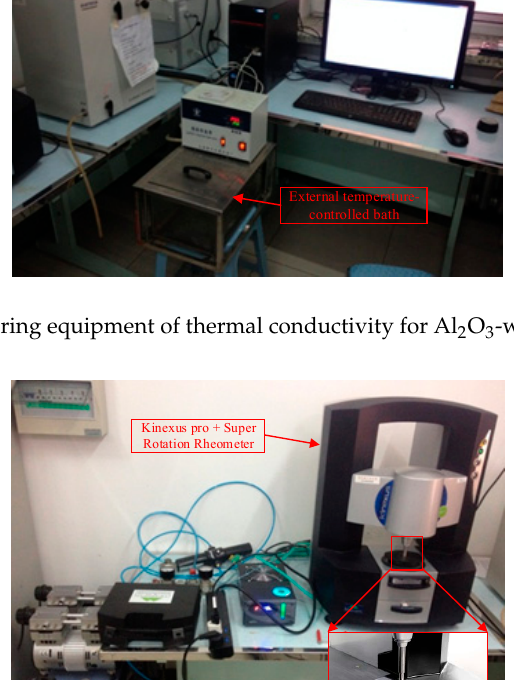
Figure 4. Measuring equipment of viscosity for Al 2 O 3 -water nanofluids.